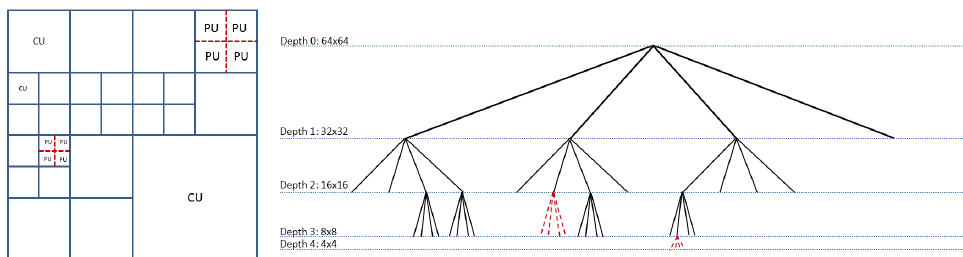
Figure 1. A splitting example of a coding unit (CU) in intra-coding. Left part shows the final splitting result of a CU. Right part is the corresponding structure of quad-tree, in which black solid lines are CU splitting branches and dot red lines are splitting branches for prediction units